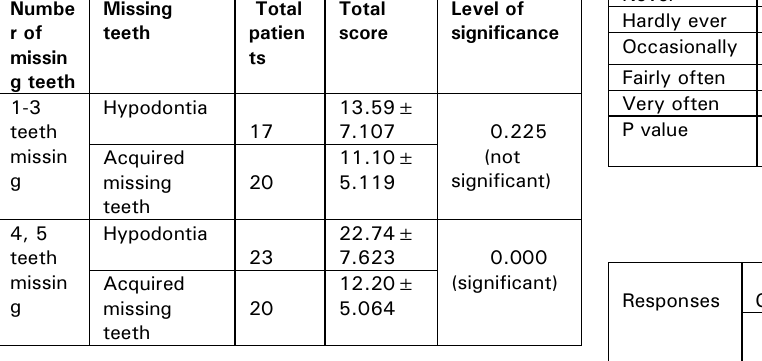
Table 1: Comparison of ohrqol in hypodontia patients and patients with acquired missing teeth Numbe r